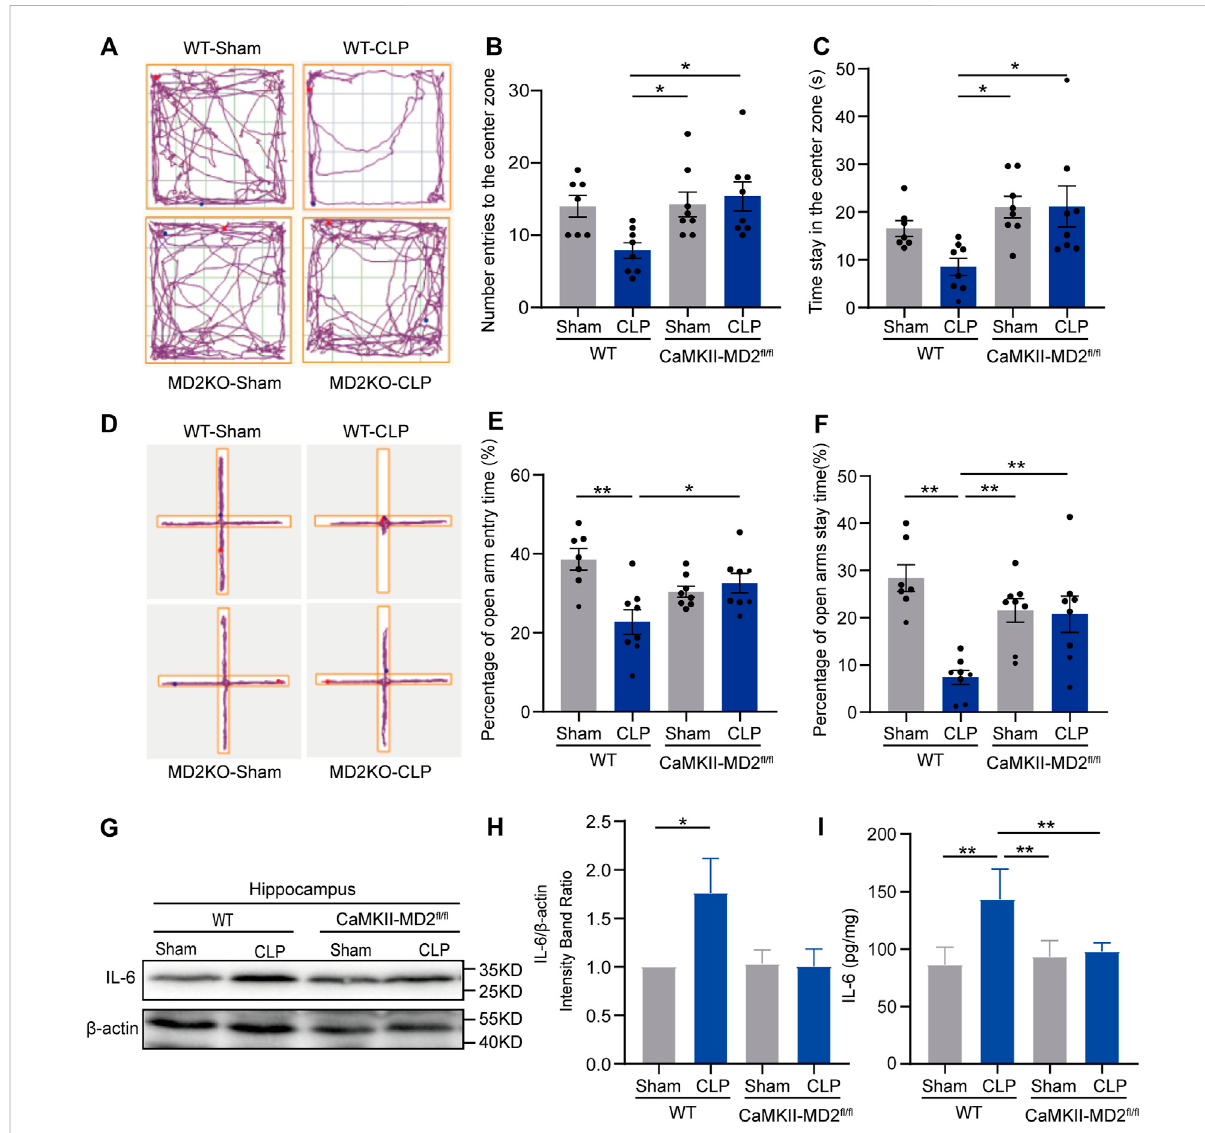
FIGURE 6 Depression-like behaviors were reduced in the CaMKII-MD2 fl / fl mice at 14 d after CLP. (A) . Typical tracking chart of the OPF between the CaMKII-MD2 fl / fl mice and theWT mice. (B) . The differences betweentheWT and CaMKII-MD2 fl / fl groups innumberof entries tothe centerzone. (C) . The differences intime spent in thecenter zonein theOFT (n sham-WT= 7, others n = 8). * p < 0.05. Data are shown as the mean ± SEM. (D) . Typical tracking chart of the EPM between the CaMKII-MD2 fl / fl mice and the WT mice. (E) . The percentage of entries to the open arms. (F) . The percentage of time spent in the open arms (n sham-WT = 7, others n = 8). * p < 0.05, ** p < 0.01. Data are shown as the mean ± SEM. (G) . RepresentativeWesternblotsofIL-624 hafterCLP. (H) .QuantitativeevaluationofIL-6inthehippocampus.* p < 0.05.Dataareshownasthemean± SEM (n = 8). (I) . ELISA analysis of IL-6 in the hippocampus among different groups. ** p < 0.01. Data are shown as the mean ± SEM ( n =